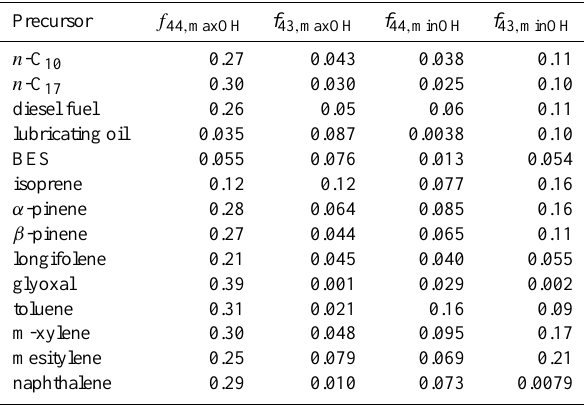
Table 2. Average Van Krevelen slopes [(H/C)/(O/C)] of PAM- generated SOA/OPOA. Typical slope uncertainty is 10–20